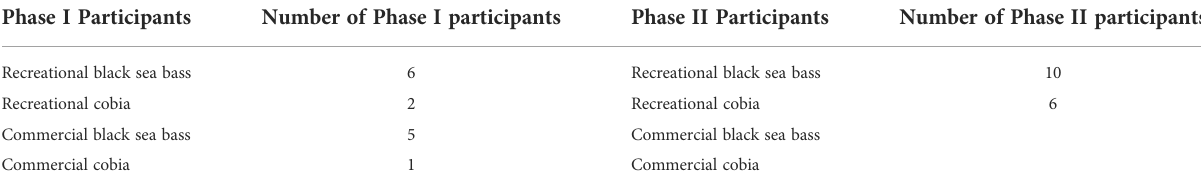
TABLE 1 Interview participation by sector (recreational or commercial) and species (black sea bass or cobia) by phase (1 or 2). Phase I